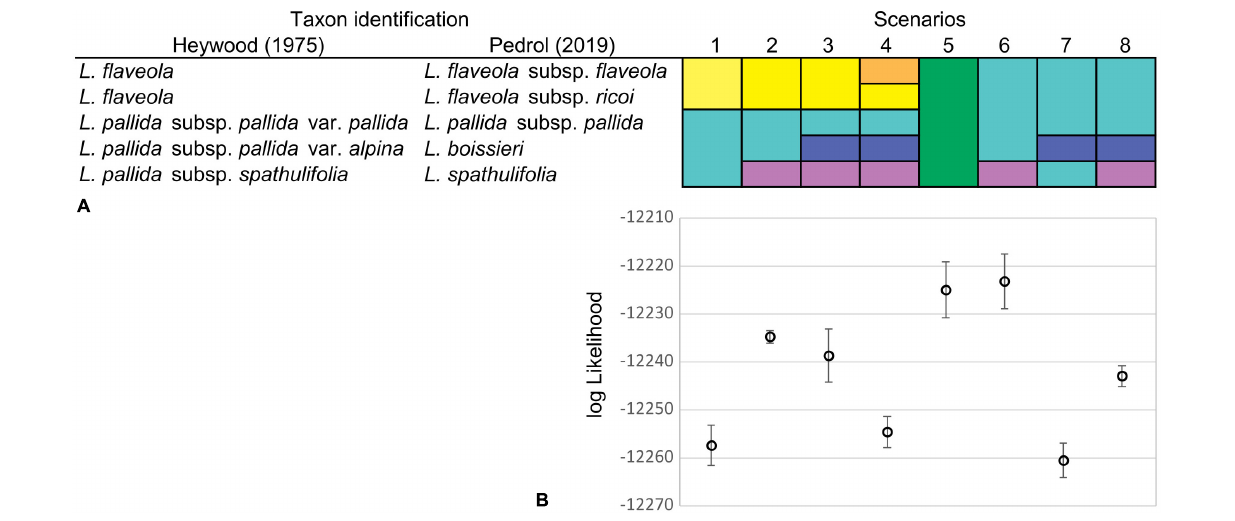
FIGURE 4 | (A) Species delimitation scenarios were investigated for the Iberian tetraploid taxa of Leucanthemopsis . Taxa recognized by Heywood (1975) and Pedrol (2019) were merged into different potential tetraploid lineages. Different colors in a scenario denote different lineages delimited (e.g., in scenario one, two species are delimited). (B) Means and standard deviations of marginal-likelihood estimates from five replicate analyses for each of the species classification scenarios of the Iberian tetraploid taxa. Marginal likelihoods were estimated via Path Sampling (PS) in the Model Selection package v1.3.4 of B EAST 2. TABLE 1 | Averaged fluorescent ratios (relative DNA content) and inferred ploidy for different taxa of Leucanthemopsis as obtained by flow-cytometric measurements. Taxon 2 n Leucanthemopsis / Petunia ratio Ploidy Individuals Populations Mean